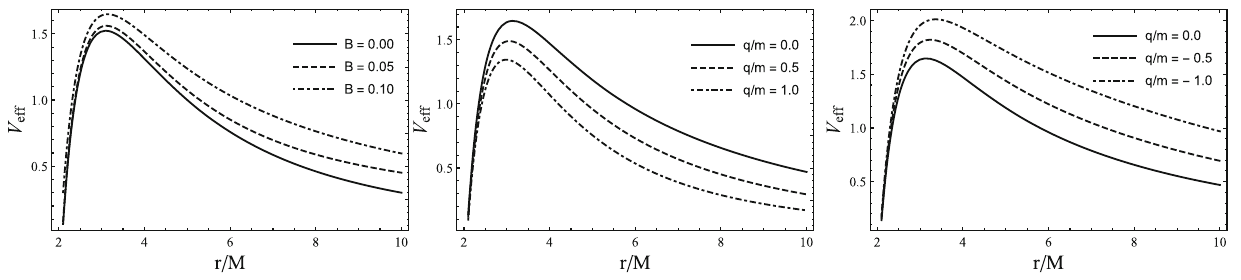
Fig. 2 Radial dependence of the effective potential for the radial motion of test particles around the magnetized Ernst black hole. Left panel: V eff is plotted for various combinations of B for the neutral par-